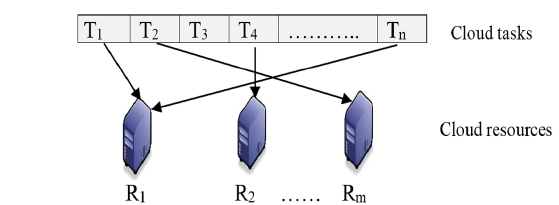
Figur e 2. Cloud Resource Scheduling Problem